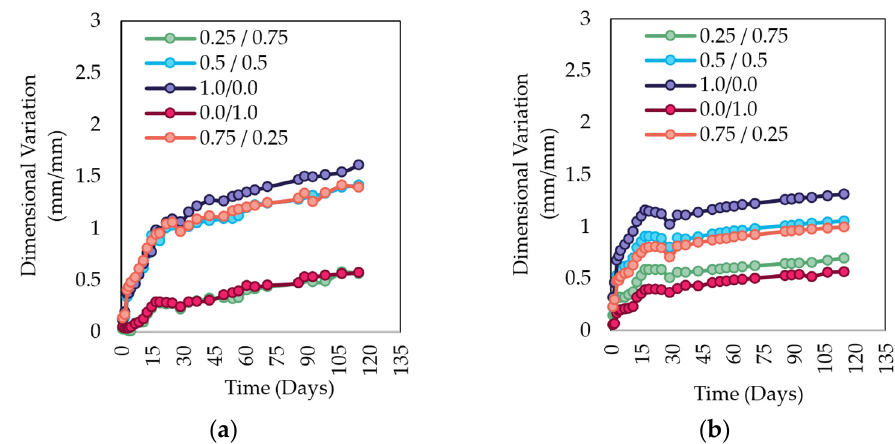
Figure 14. Shrinkage of the mortars using CAA design with ( a ) sealed or ( b ) unsealed curing.